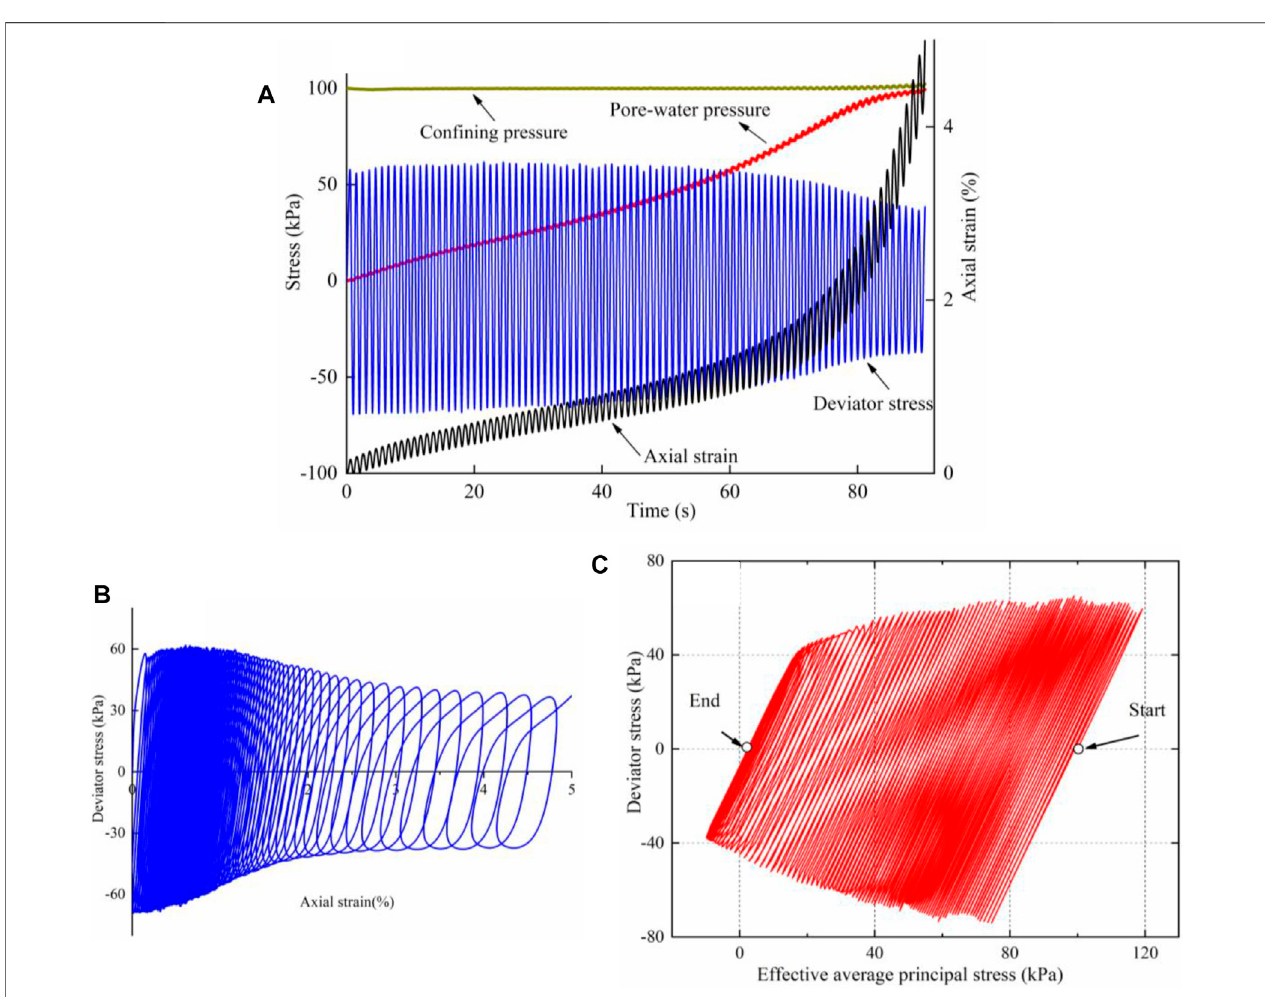
FIGURE 5 | Test results of cyclic triaxial test: (A) time-series data of pore-water pressure, axial strain, con fi ning pressure and deviator stress (B) stress-strain hysteresis curve, and (C) effective stress path.